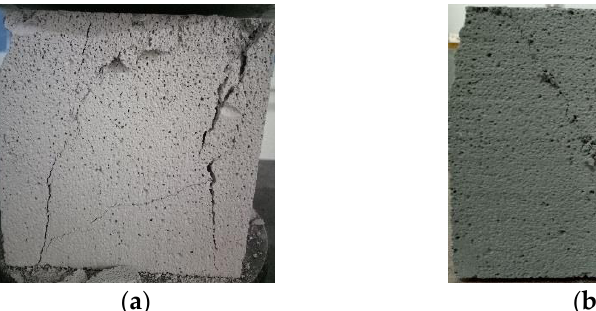
Figure 12. Failure mode of AAC cubic compression: ( a ) vertical crack, ( b ) oblique crack, ( c ) corner crack.